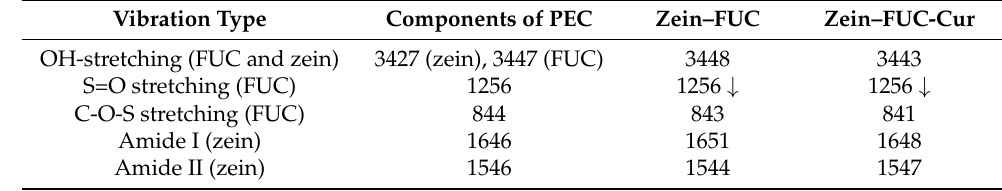
Table 3. FT-IR bands (cm − 1 ) observed in zein–FUC and zein–FUC-Cur particles [36]. Vibration